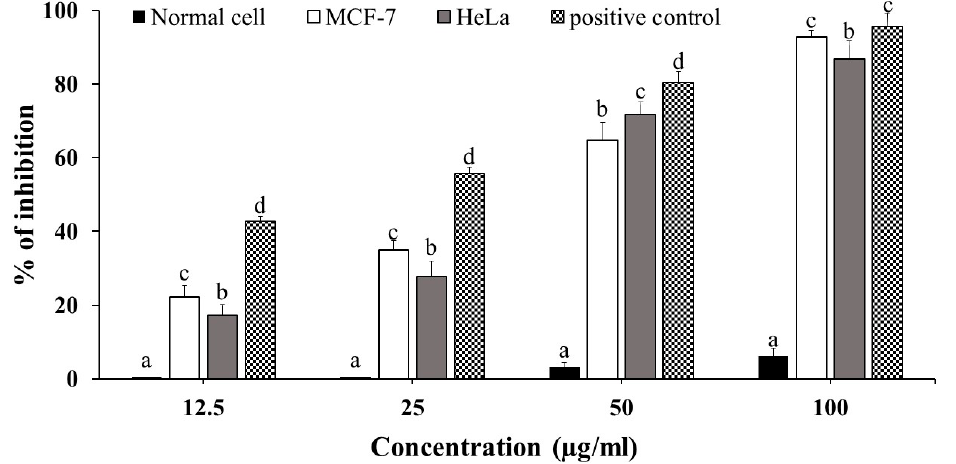
Figure 4. Cytotoxicity dose–response of mangiferin on the viability of MCF-7 and HeLa cell lines and Vero normal cell lines at various doses ranging from 12.5 to 100 µg/mL using the MTT test. The IC 50 values were recorded to be 41.2 and 44.7 µg/mL for MCF-7 and HeLa, respectively. Different letters denote significant differences ( p < 0.05) within the same concentrations of mangiferin. The results are represented by the mean ± SD of three independent experiments.